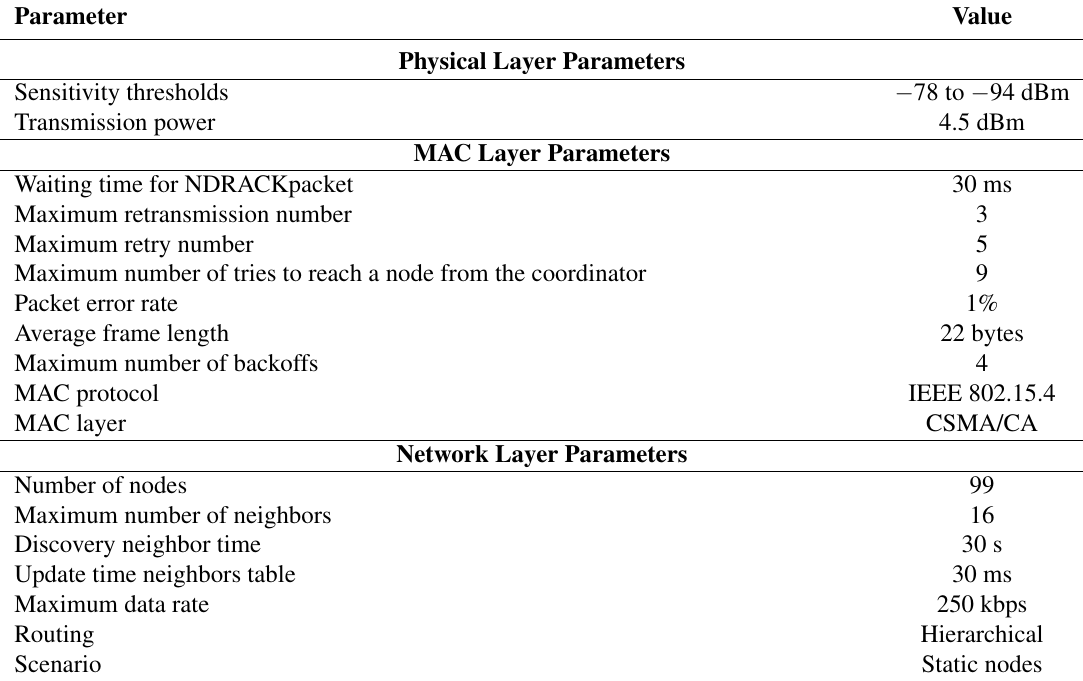
Table 1. Simulation and real network parameters. CSMA/CA, carrier sense multiple access with collision